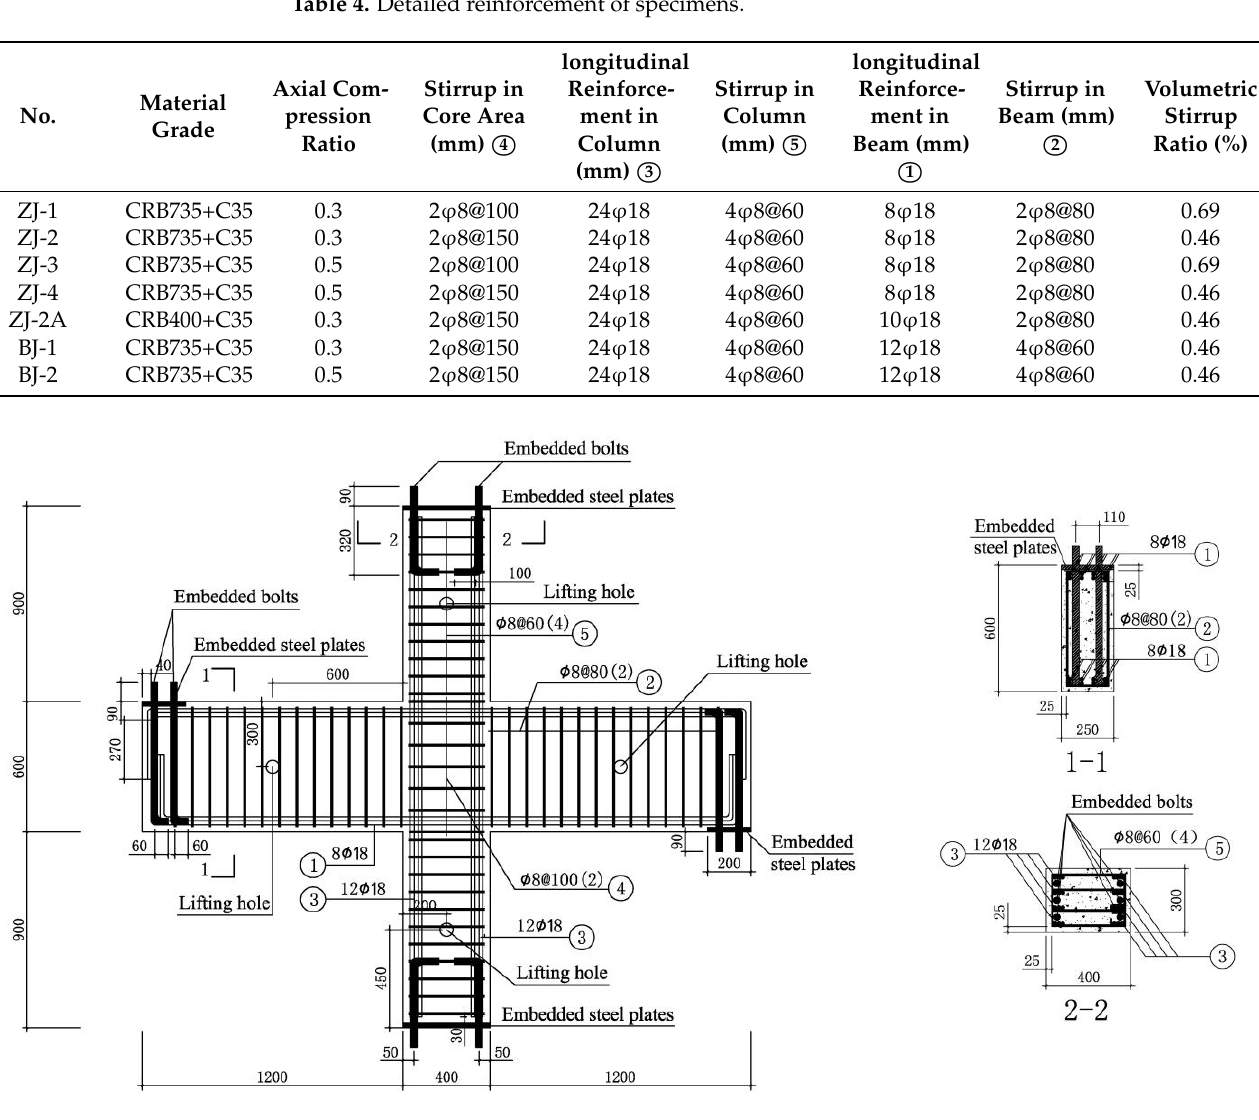
Figure 4. Dimensions and reinforcement of specimens ZJ-1 and ZJ-3 (Unit: mm).